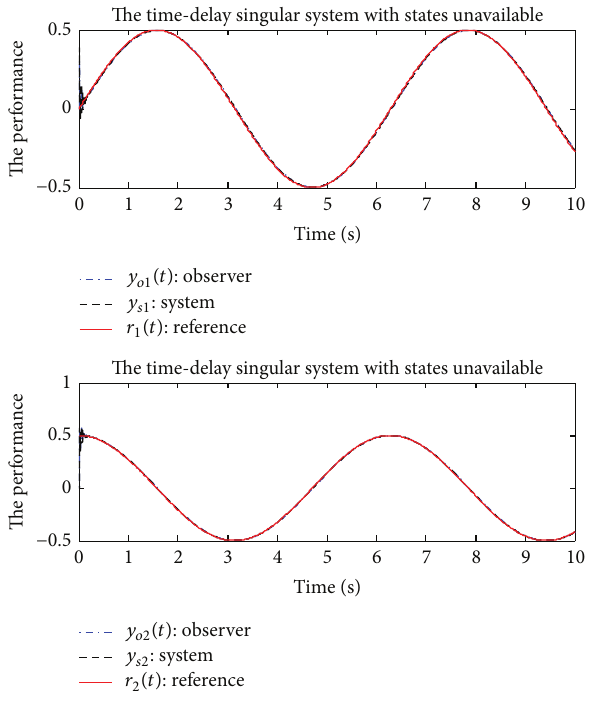
Figure 4: Output responses of time-delay singular system with states unavailable by new observer-based suboptimal approach.